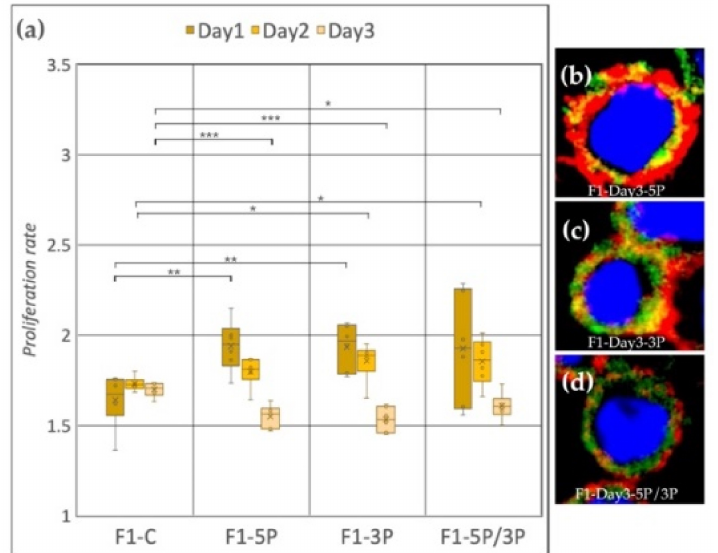
Figure 6. ( a ) Proliferation rate of F1 (ZW genotype) PGC line on Day 1, Day 2 and Day 3. F1-C: non-inhibited, F1-5P: gga-miR-302b-5P inhibition, F1-3P: gga-miR-302b-3P inhibition, F1-5P/3P: gga-miR-302b-5P and gga-miR-302b-3P inhibition. ( b – d ) Immunostaining of F1 PGCs after three days of cultivation with different culture conditions. The immunostaining was achieved with SSEA-1 (red), CVH (green) and TO-PRO™-3 for nuclear staining (blue) ( p < 0.05 *, p < 0.01 **, p < 0.001